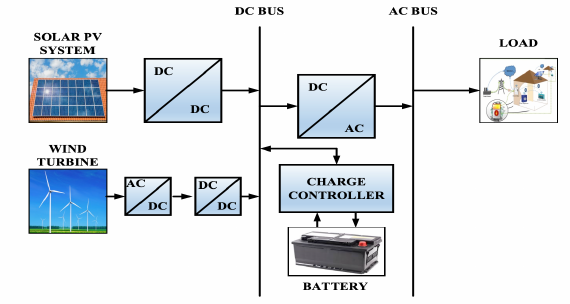
Fig. 2. Block diagram of renewable energy system